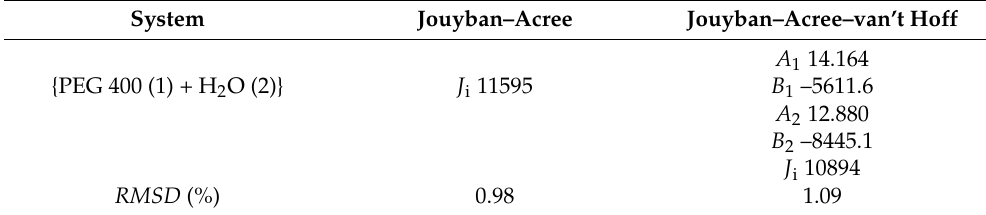
solvent compositions. Table 9 documents the outcomes of the correlation with the “Jouyban– Acree and Jouyban–Acree–van’t Hoff models”. The overall RMSDs for the “Jouyban–Acree and Jouyban–Acree–van’t Hoff models” were computed to be 0.98% and 1.09%, respectively. Table 9. Results for “Jouyban–Acree” and “Jouyban–Acree–van’t Hoff” models for FXT (3) in different {PEG 400 (1) + H 2 O (2)} mixtures.